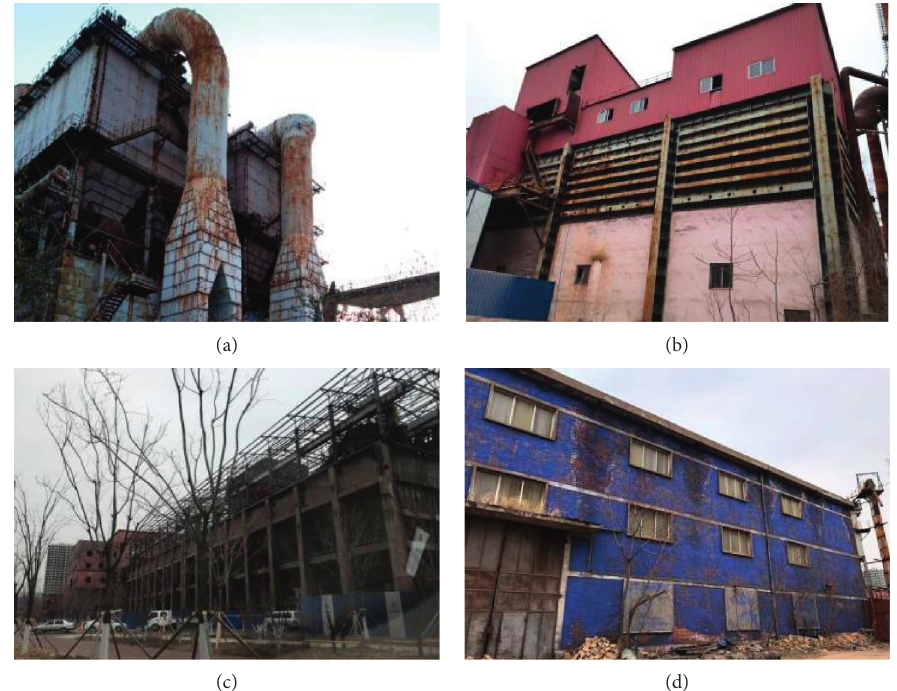
Figure 5: Status of some buildings. (a) Blast furnace with dedusting. (b) Warehouse. (c) Transfer station. (d) Spare parts warehouse.